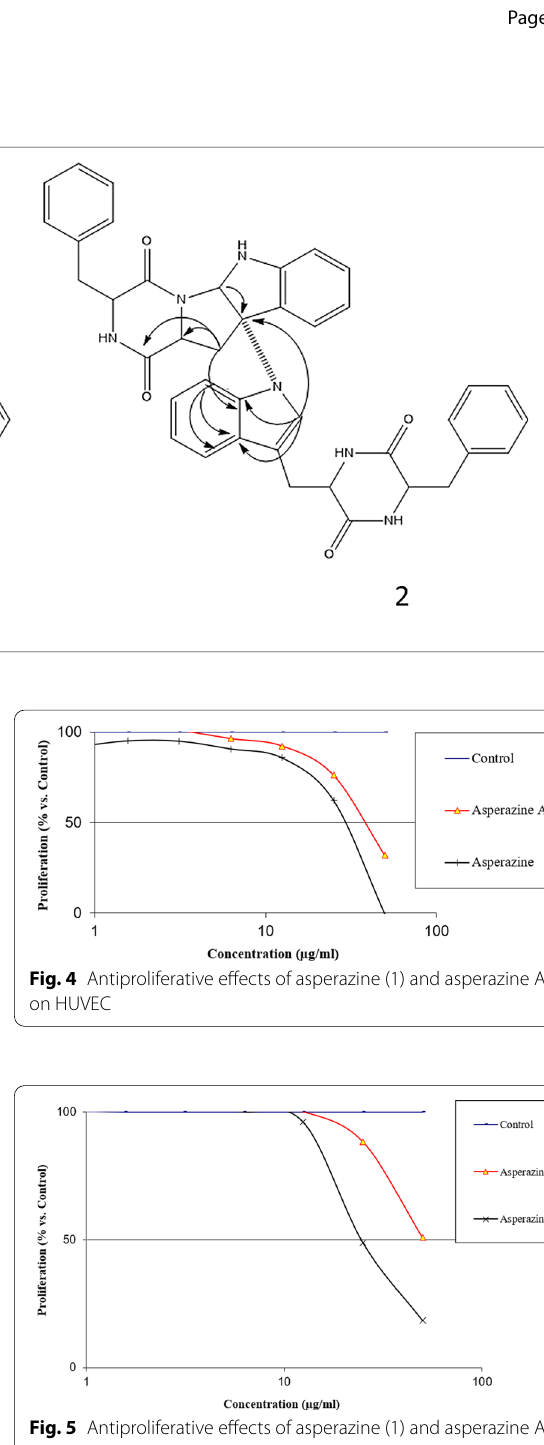
(K-562). A value of 19.2 µg mL − 1 was obtained for the CC 50 of asperazine against HeLa cell line and GI 50 val- ues of 31.4 and 24.6 µg mL − 1 against HUVEC and K-562 cell lines, respectively (Figs. 4, 5). In a reported study